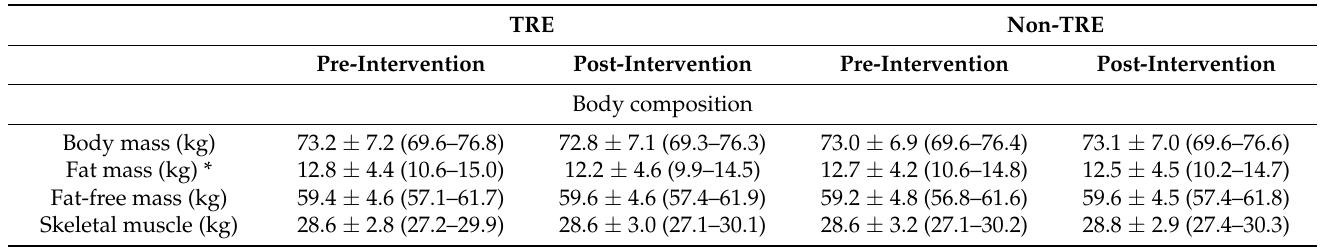
Table 2. Changes in body composition after four weeks of time-restricted eating (TRE) and habitual diet (non-TRE). TRE Non-TRE Post-Intervention